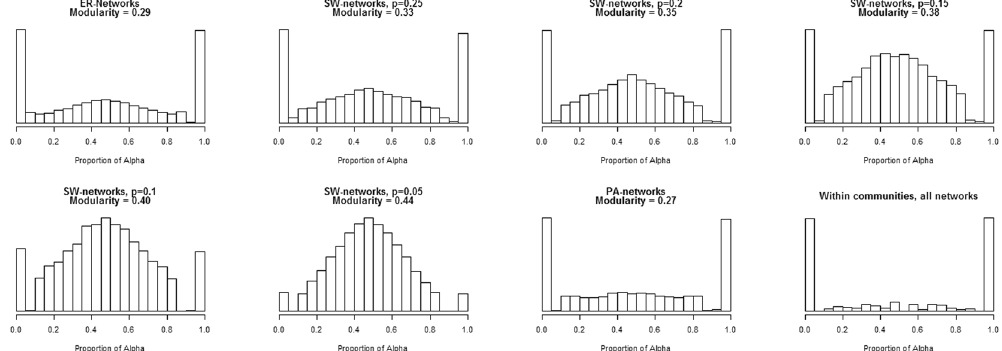
Figure 1. Proportion of α played in a network after convergence for ER-networks, SW-networks with rewiring probability 0.25, SW-networks with rewiring probability 0.2, SW-networks with rewiring probability 0.15, SW- networks with rewiring probability 0.1, SW-networks with rewiring probability 0.05, PA-networks and within communities of all